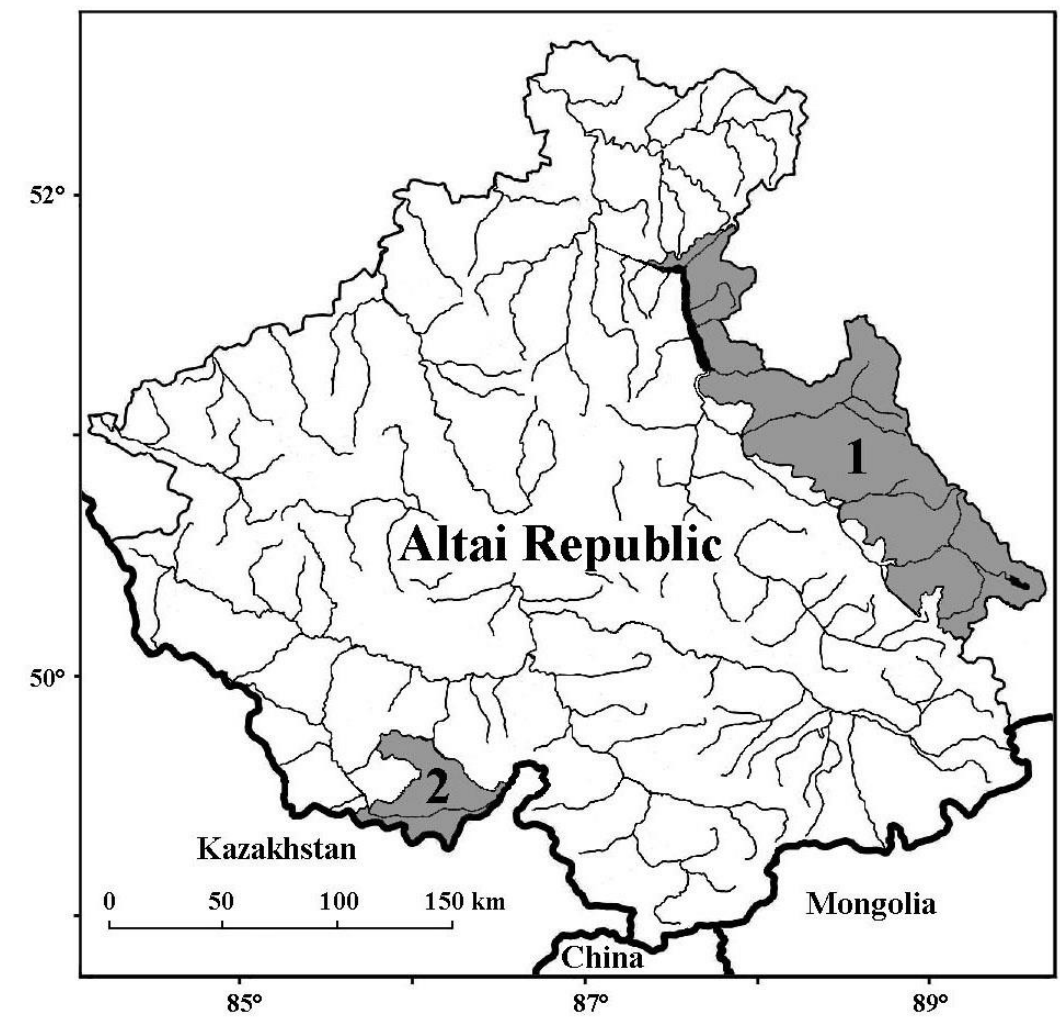
Fig. 1 State Nature Biosphere Reserves of the Altai Republic: 1 – Altaiskiy State Nature Biosphere Reserve, 2 – Katunskiy State Nature Biosphere